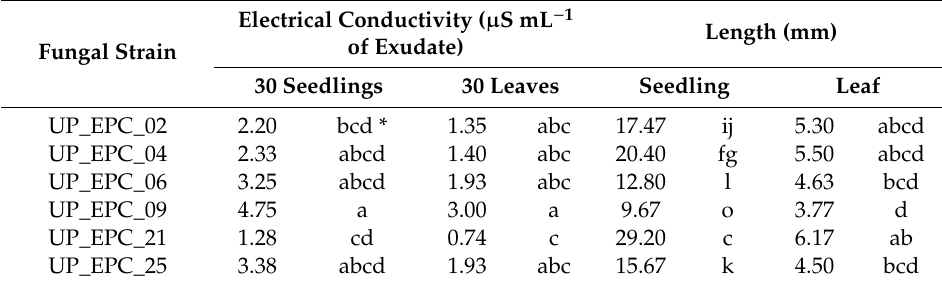
Table A2. E ff ect of the culture filtrates from 18 strains of E. nigrum on electrical conductivity of exudates from garden cress ( L. sativum L.) and their growth after 7 days incubation with culture filtrates, the control groups with medium and with distilled